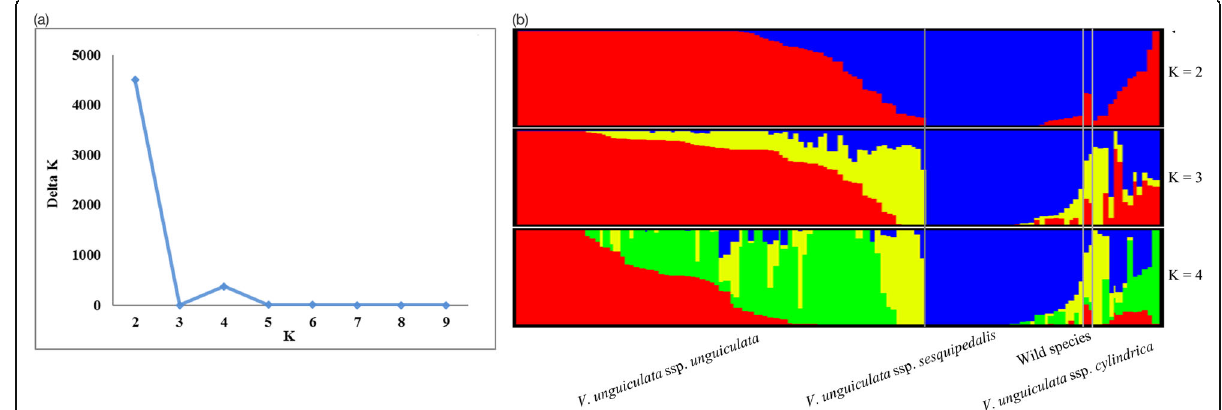
Fig. 2 Population structure analysis for 130 cowpea accessions. A Plot of the Δ K value with the number of subpopulations ( K ) from 2 to 9 based on the Evanno test. B Distruct plot with each accession represented by a vertical line, and cluster assignments indicated by color